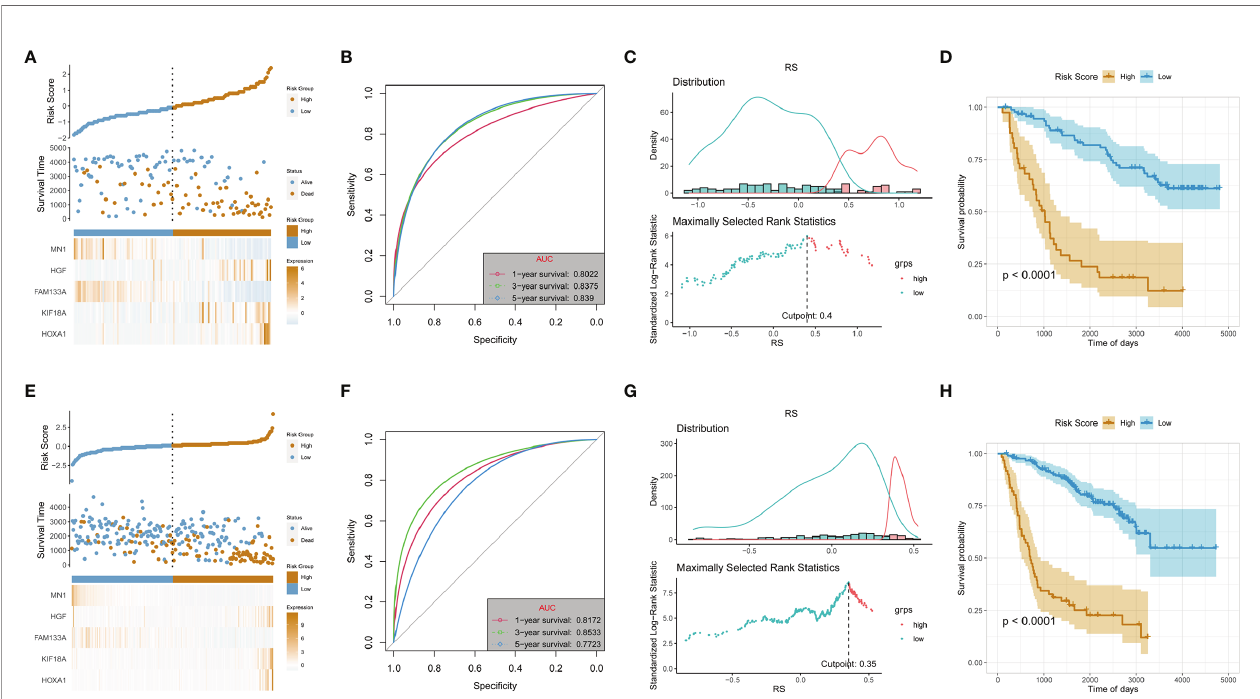
FIGURE 3 | Validation of risk signature in the test dataset (CGGA_325 cohort) and validation dataset (CGGA_693). (A, E) Allocation of patients in the training set on the basis of the risk score in the test and validation dataset. (B, F) Area Under the Curve (AUC) of 1-, 3-, and 5-year receiver operating characteristic (ROC) curves examined the prognostic performance of the risk score in the test and validation dataset. (C, G) Determine the optimal cut point for risk score in the test and validation dataset. (D, H) Kaplan – Meier curves display the diversity in OS between the low- and high-risk score groups in the test and validation